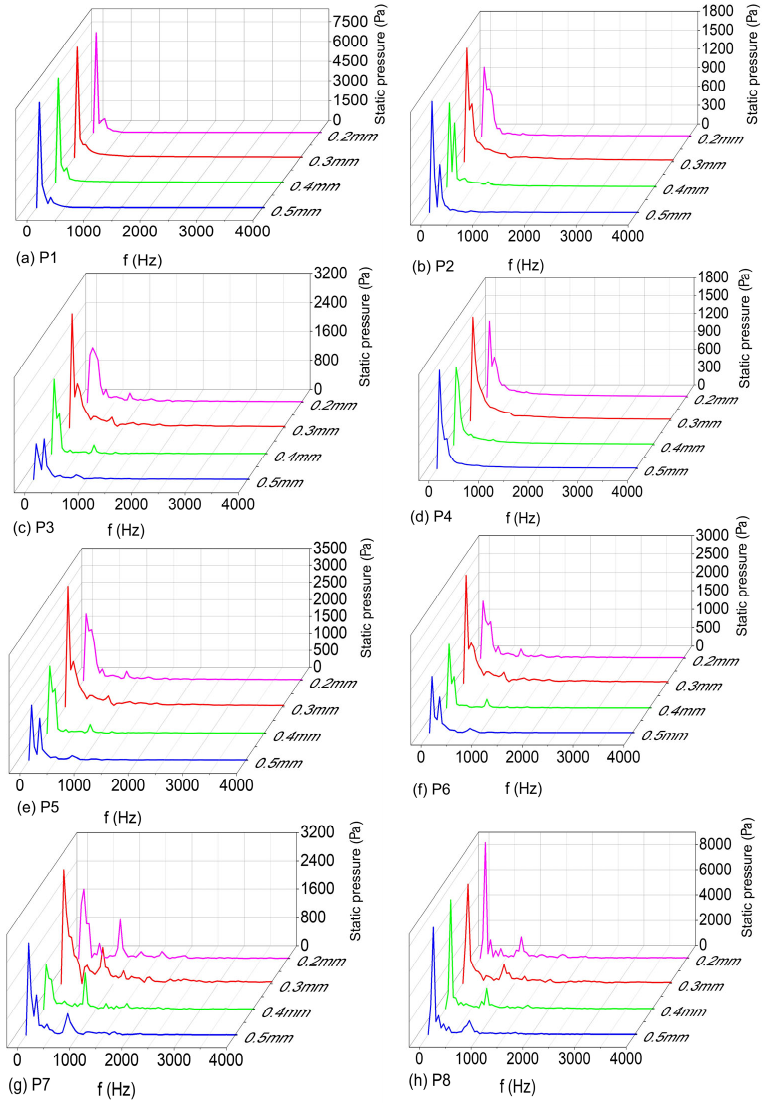
Figure 10. Frequency domain diagram of pressure fluctuations at monitoring points: ( a ) P1, ( b ) P2, ( c ) P3, ( d ) P4, ( e ) P5, ( f ) P6, ( g ) P7 and ( h )